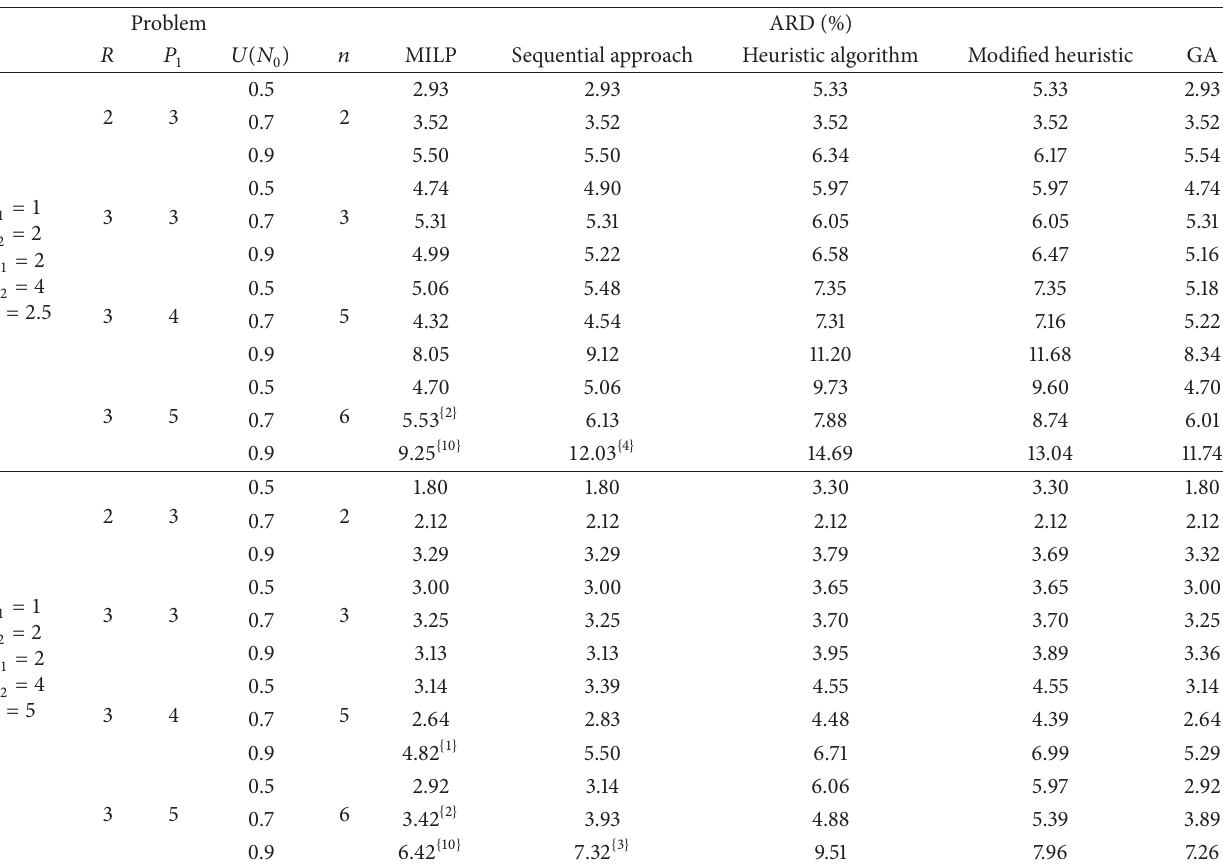
Table 1: The performance for smaller scale